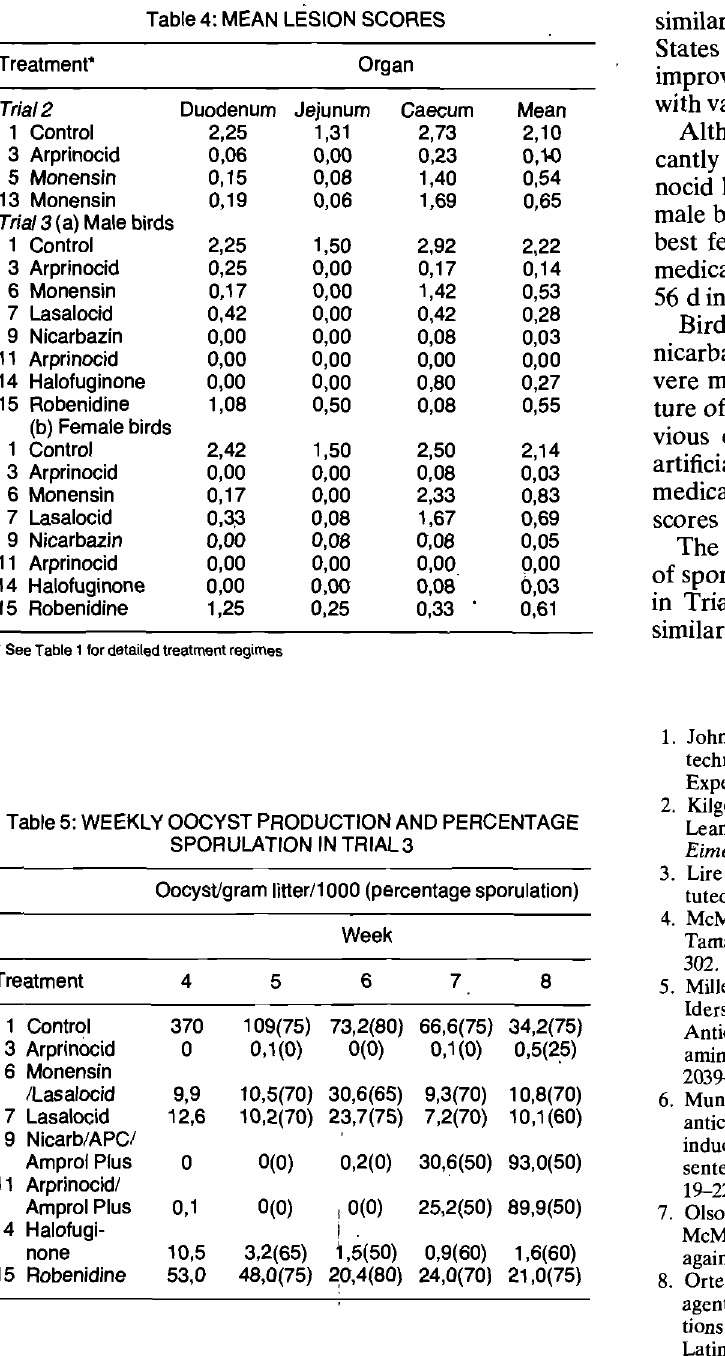
Table 5: WEEKLY OOCYST PRODUCTION AND PERCENTAGE SPORULATION IN TRIAL 3 Oocyst/gram Iitter/1 000 (percentage sporulation) Week Treatment